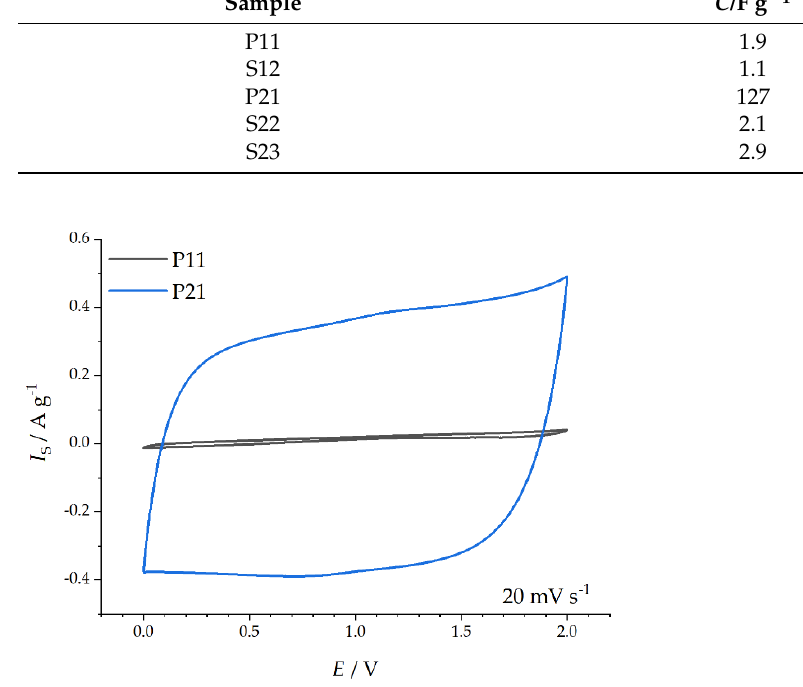
Figure 5. CV curves of samples P11 and P21 at the scan rate of 20 mV s − 1 in TEMA BF 4 in PC solution.